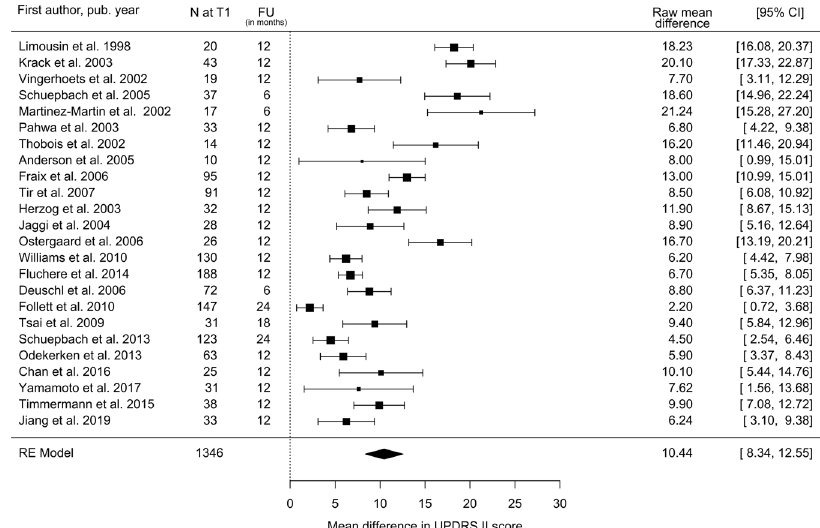
Fig. 1 Estimated decrease in total UPDRS II score following STN-DBS. Postoperative stimulation-ON/medication-OFF vs. preoperative OFF- medication state: UPDRS II Mean Difference. N = number of subjects at follow-up; FU = follow-up time; CI = con fi dence interval; RE Model = random-effects model.